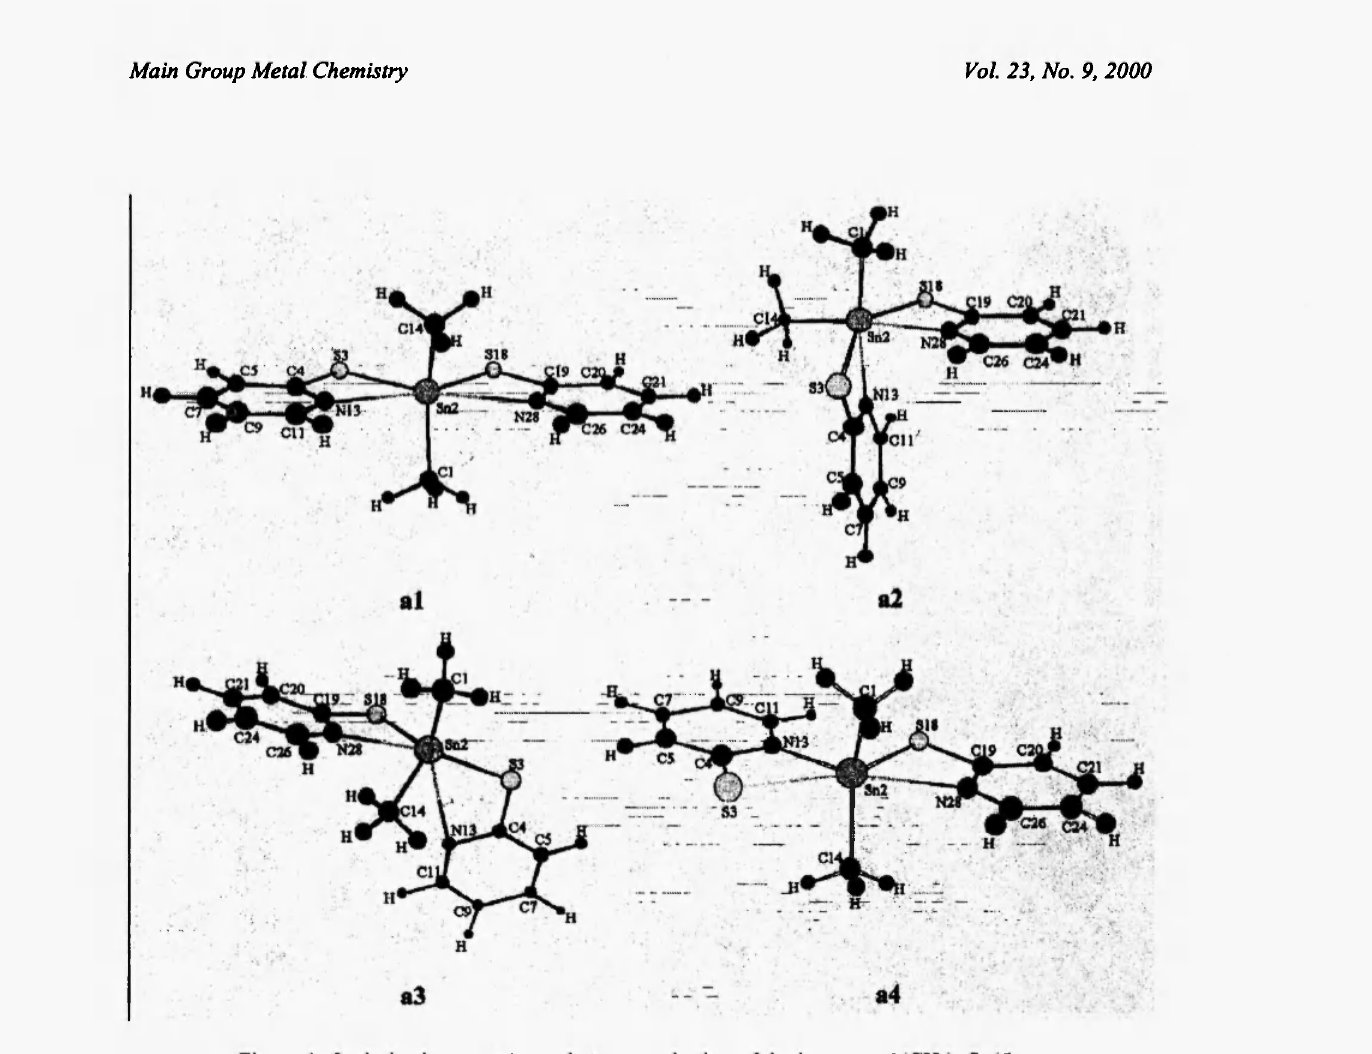
Figure 1: Optimized geometries and atom numbering of the isomers of (CH3) 2Sn(Sp y )2 (CH 3 ) 2 SnCI(SP y )